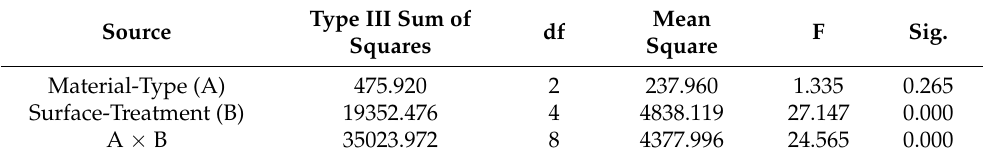
Table 2. Two-way ANOVA results.